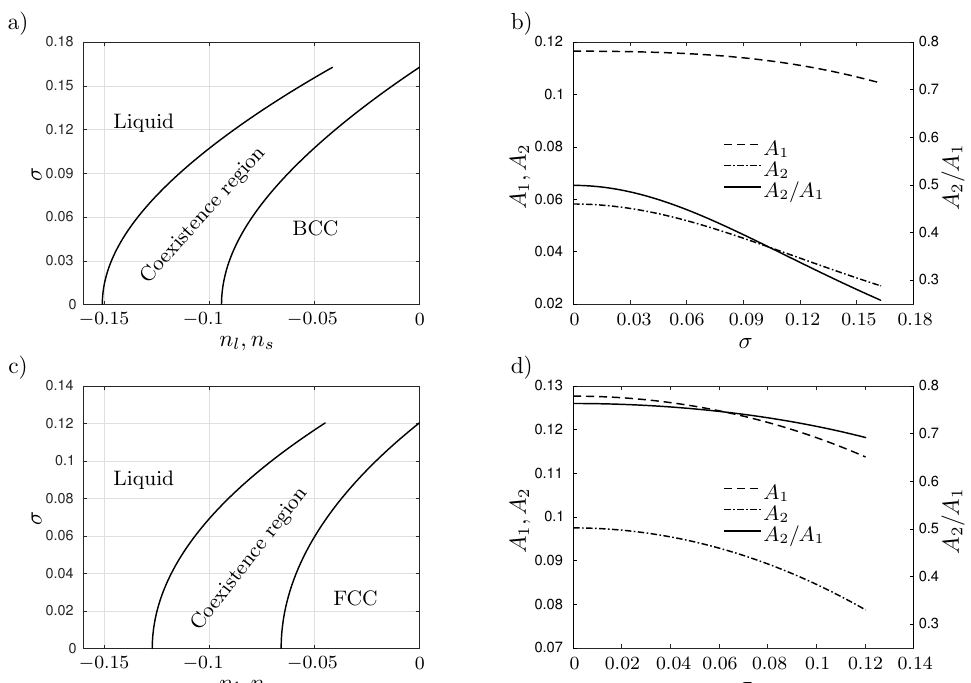
Figure A1. ( a ) Phase diagram for liquid and BCC phases. ( b ) Density field amplitudes for BCC, Equation (A3). ( c ) Phase diagram for liquid and FCC phases. ( d ) Density field amplitudes for FCC, Equation (A4). Note that the horizontal axes in figures a and c show both n l and n s as the lines separating liquid/coexistence and solid/coexistence are plotted in the same